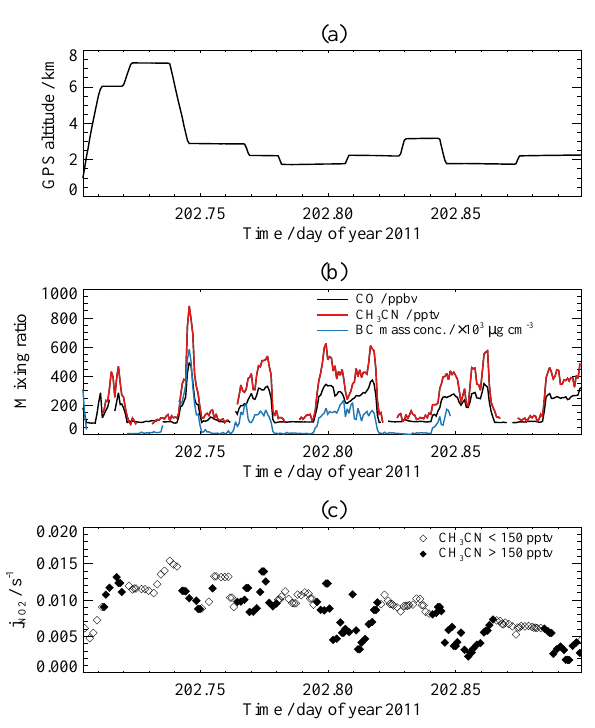
Fig. 11. Section of BORTAS flight B624 on 21 July 2011 showing (a) aircraft GPS altitude in km; (b) mixing ratios CO in ppbv and CH 3 CN in pptv and black carbon mass concentration in units of 10 3 µ gcm − 3 ; and (c) NO 2 photolysis rate, j NO 2 , in units of s − 1 . Solid symbols in (c) indicate measurements of CH 3 CN mixing ratios greater than 150 pptv to indicate plume measurements.